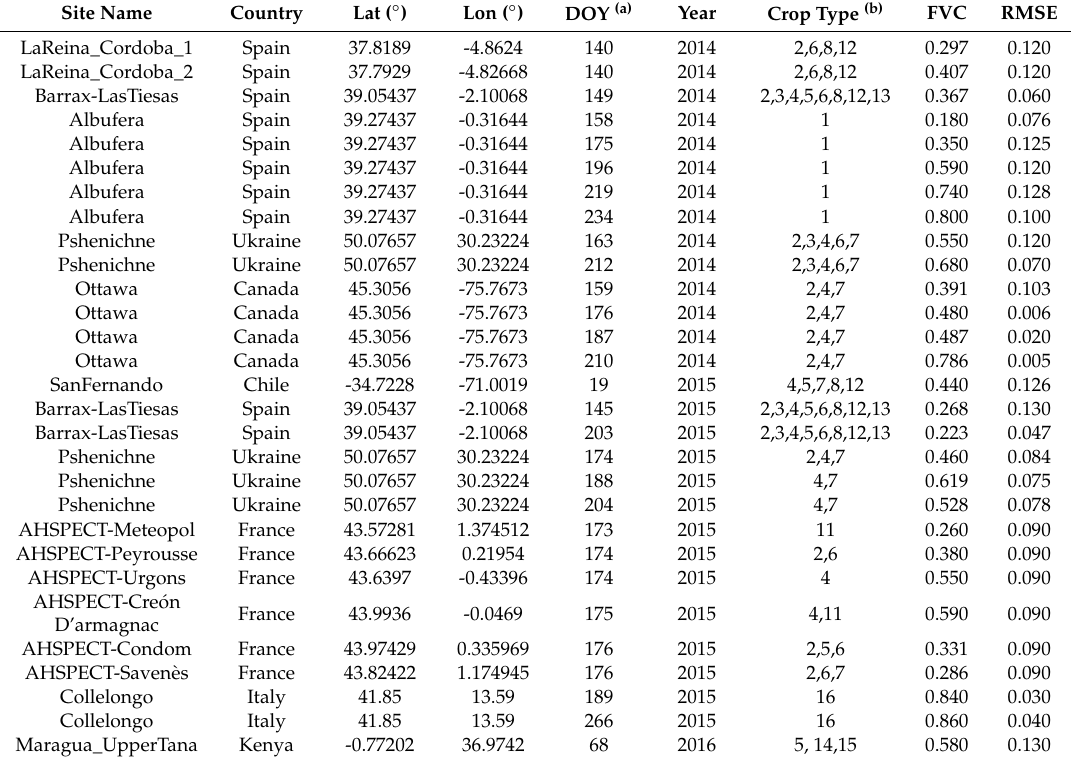
Table 2. Information of the reference